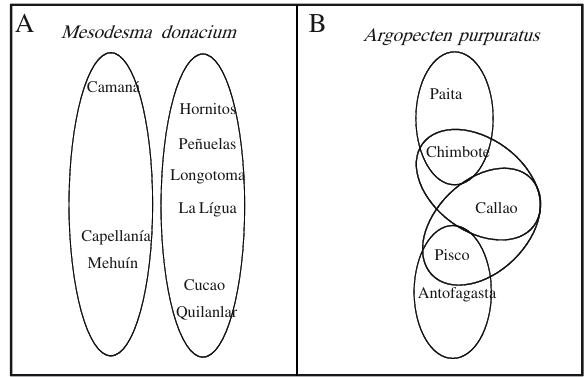
Fig . 2. – Graphic representation of the Watson-Williams test for synchrony among localities. Synchronic groups are denoted by cir-